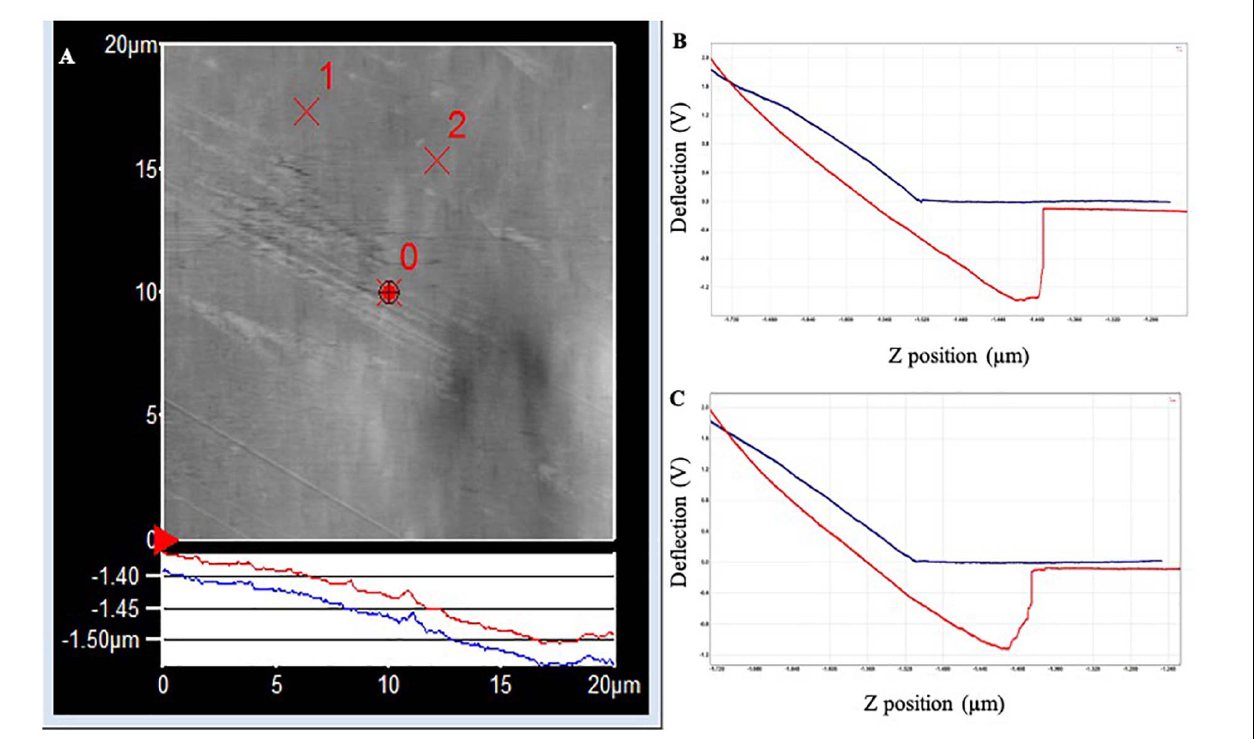
FIGURE 4 | (A) AFM topography image (20 × 20 µ m) of the PLA surface following exposure to Standard Seawater for 24 h. The force curves were acquired at the locations identified as × 1 and × 2, which did not have any apparent surface abnormalities. (B) Force–distance curve acquired at location × 1. (C) Force–distance curve acquired at location ×